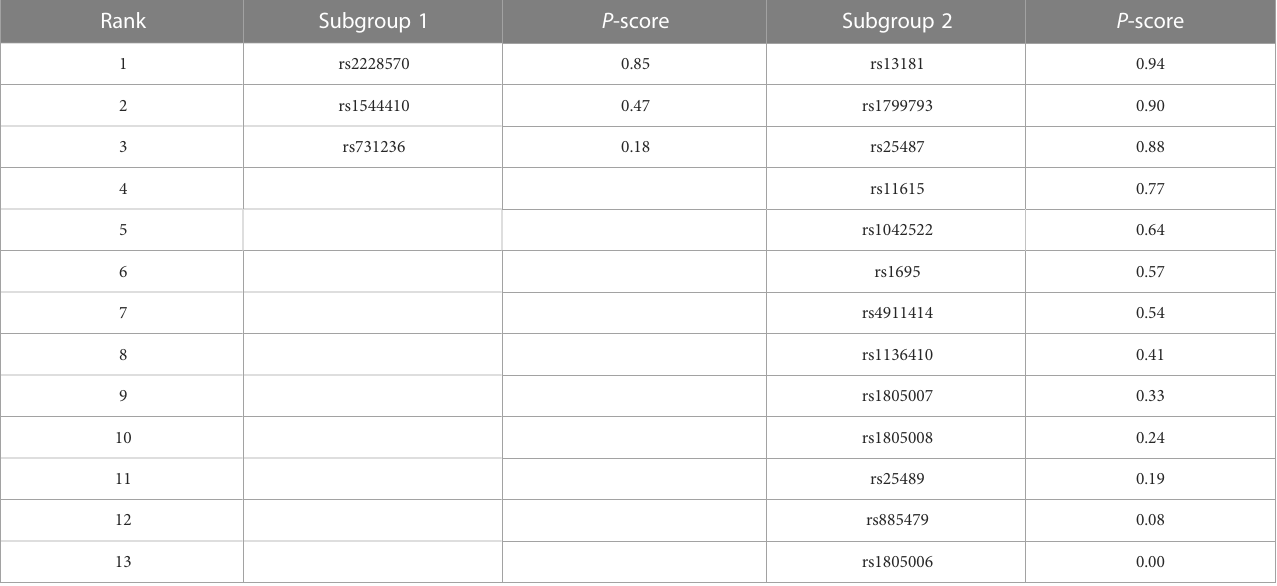
TABLE 4 The rank of the P -score of the SNPs in each subgroup in the allele model.